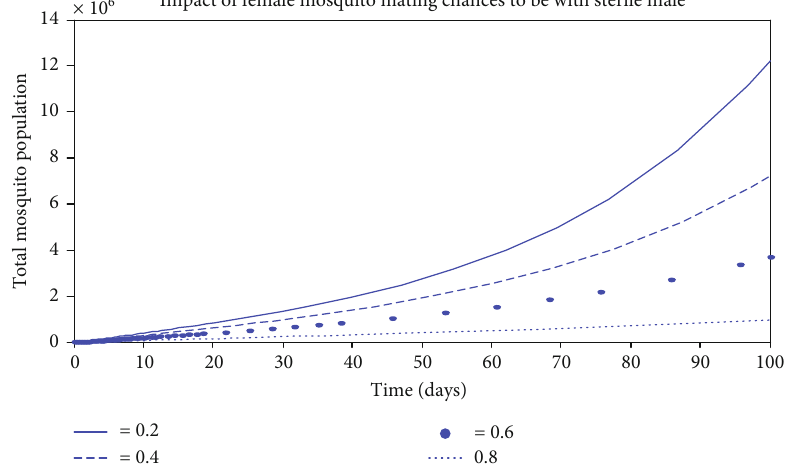
Figure 5: Impact of female mosquito mating probability ð ρ s Þ to be with the sterile male on the total mosquito population; an increase in this rate leads to a reduction in the total mosquito